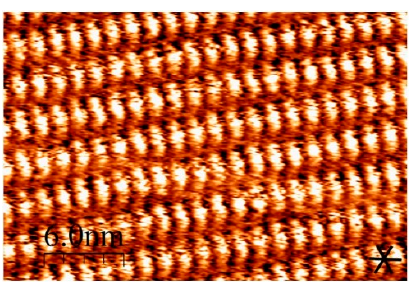
Figure 3. Larger scale STM image of [Cu(C16IND) 2 ]. Image area: 30 × 20 nm 2 .